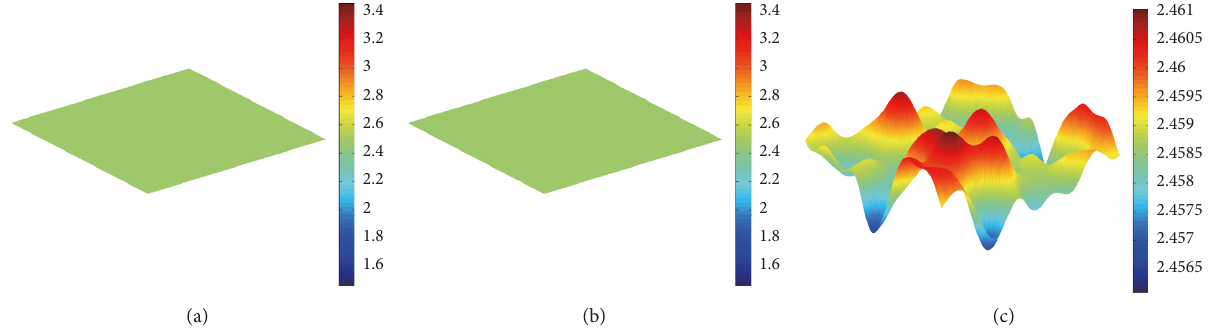
Figure 4: Spatial distribution of phytoplankton population under different time delay parameters. Parameter values: I � 1 . 6, a � 0 . 5, � 0 . 20, d � 0 . 20, q � 0 . 01, ε � 0 . 001, and t � 800. (a) τ � 0; (b) τ � 1; (c) τ � b � 0 . 8, α � 0 . 7, m � 0 . 45, d 1 2